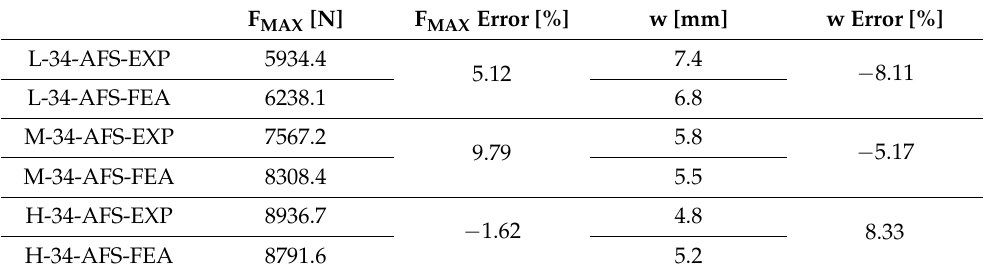
Table 3. Comparison between the simulated impact tests results and the experimental results.